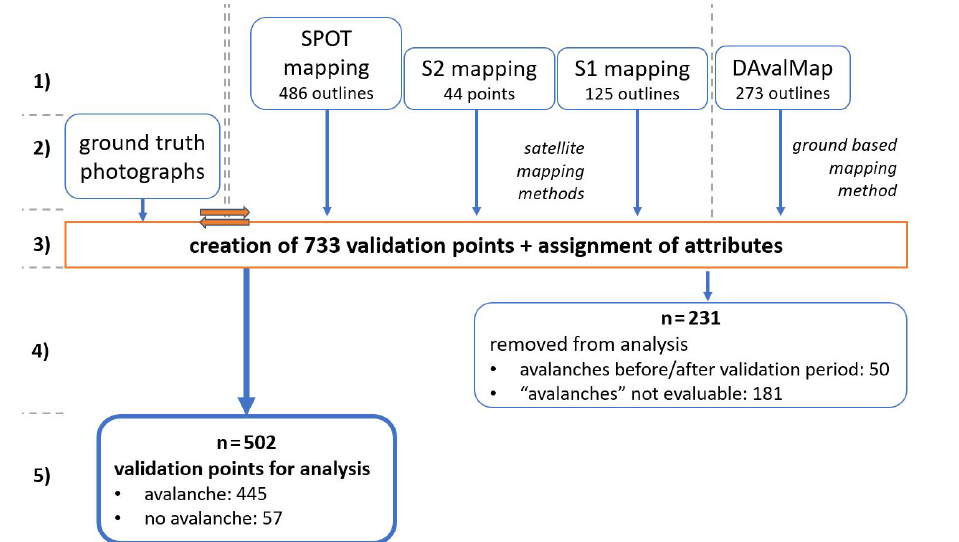
Figure 3. Steps taken from the satellite mappings to the validation results. (1) Avalanches were mapped from satellite imagery and extracted from the DAvalMap database. (2) Ground-truth data were compiled. (3) In the validation process (Sect. 3.4), symbolized by the orange arrows, validation points were created and assigned attributes (see also Appendix C). (4) Points representing avalanches from before or after the validation period or outside ground truth were removed. The remaining validation points were used for